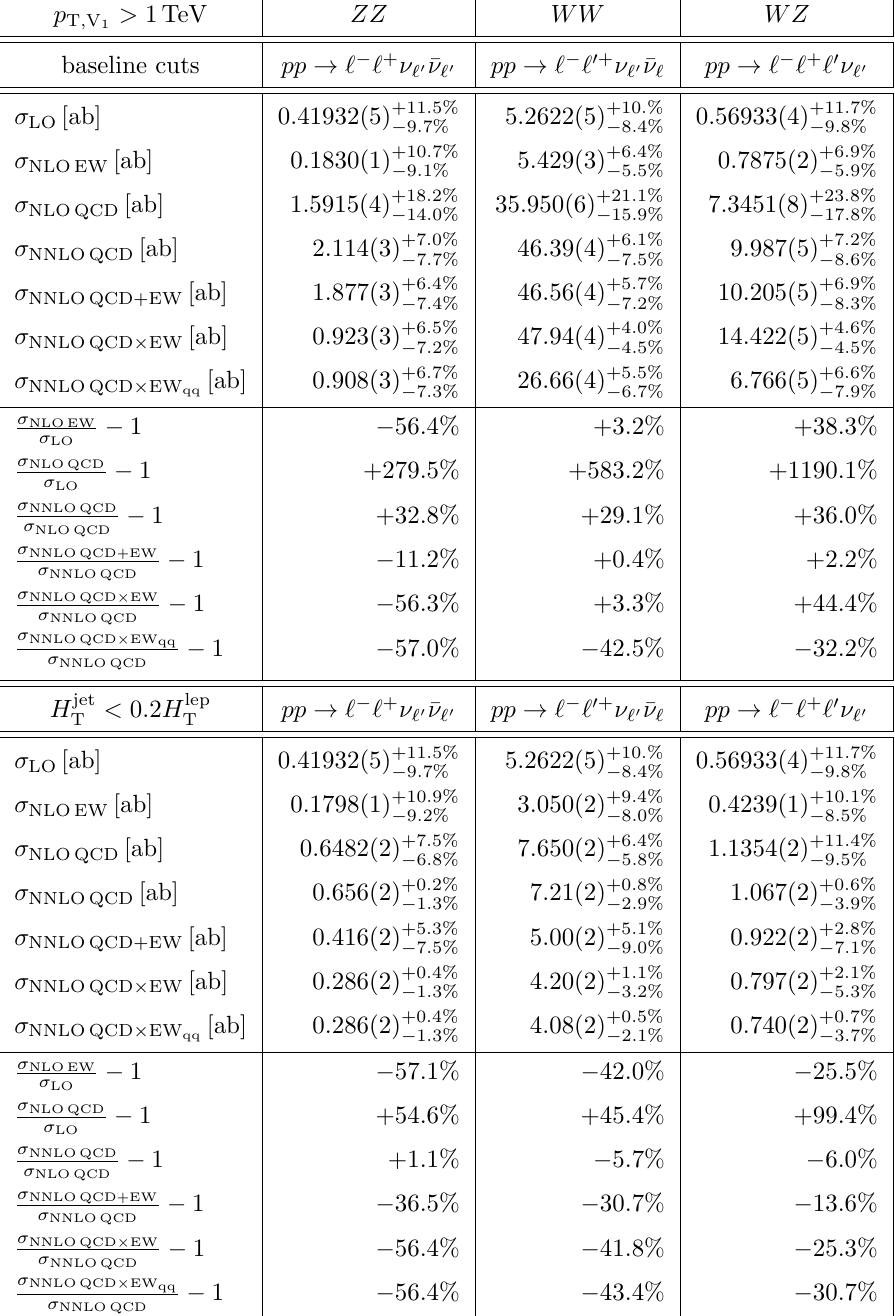
Table 4 . Integrated cross sections for the processes (3.1){(3.3) at p s = 13 TeV. The baseline cuts (3.10){(3.12) are supplemented by an additional cut on the transverse momentum of the leading vector boson, p T ; V > 1 TeV. Cross sections in the upper part of the table are inclusive 1 with respect to QCD radiation, while the lower part of the table reports corresponding results in the presence of the jet veto (3.16). The quoted uncertainties correspond to seven-point scale variations. Absolute cross sections are reported in attobarn (1 ab = 10 (cid:0) 3 fb).